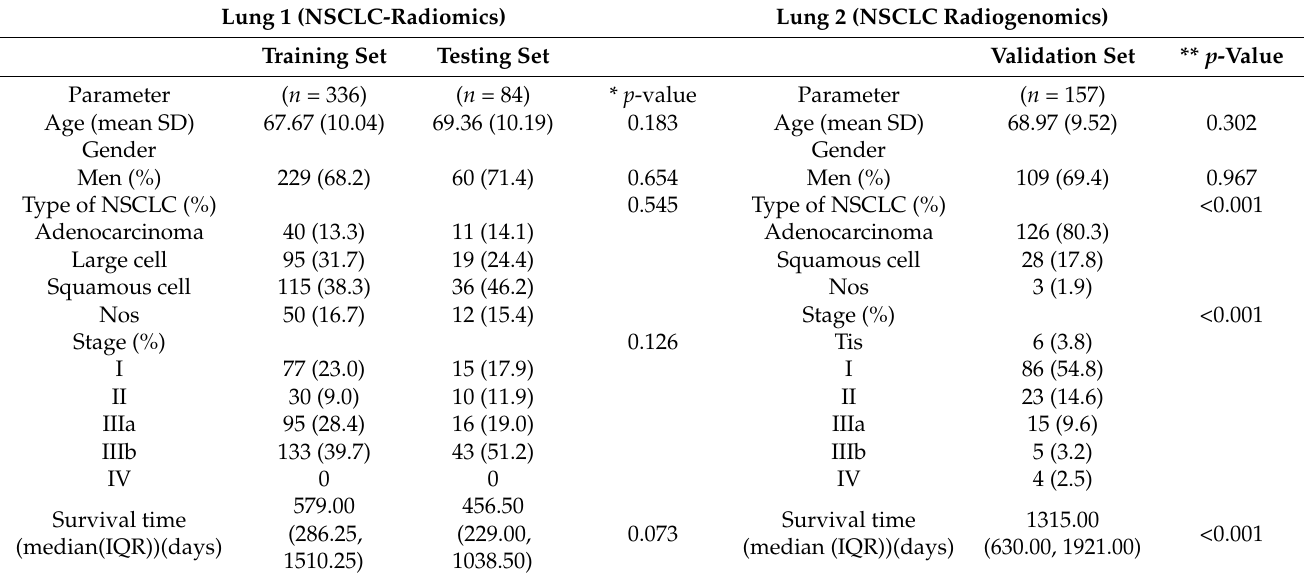
Table 1. Baseline patient